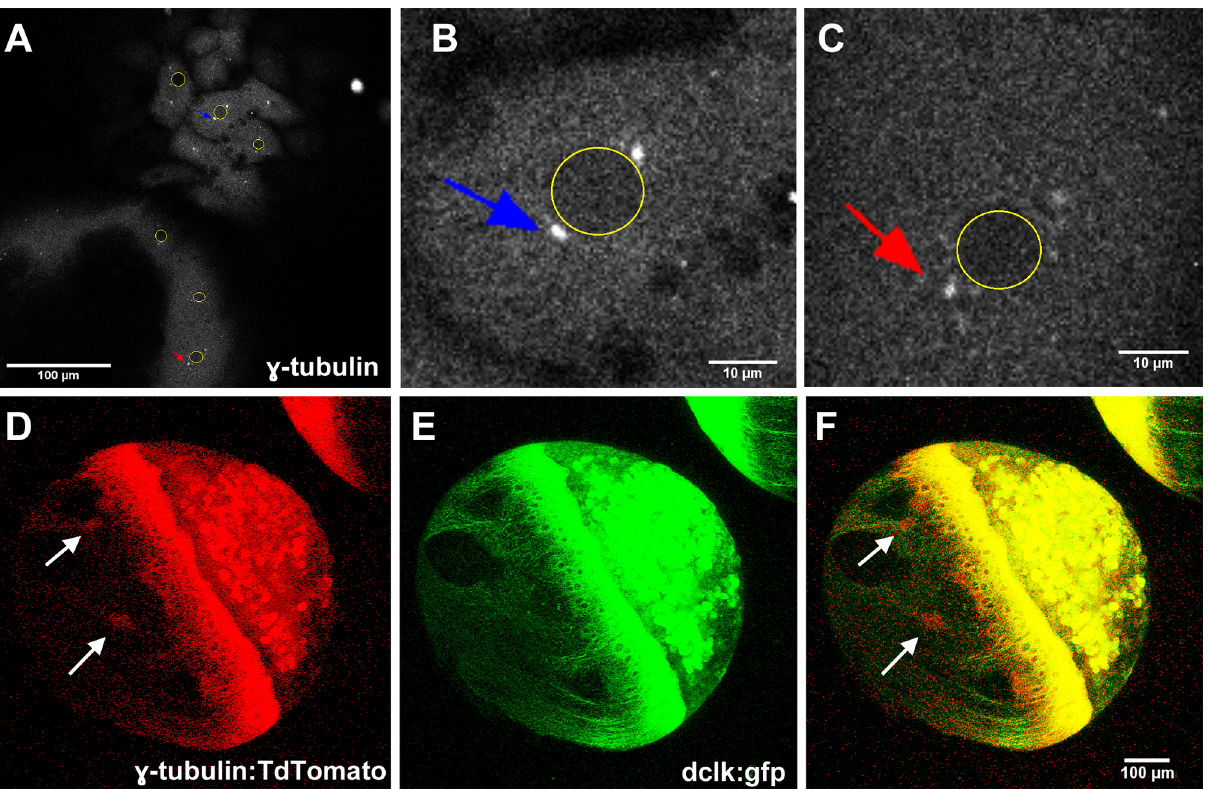
Figure 6. MT nucleation occurs at YSN centrosomes and YCL asters. γ-Tubulin expression can be observed through ( A – C ) immunostaining on fixed embryos and ( D – F ) in embryos coinjected with γ-tubulin-TdTomato mRNA and dclk2-gfp mRNA. γ-Tubulin signal has been found in ( B ) blastoderm centrosomes (blue arrow), ( C ) e-YSN centrosomes (red arrow) and ( D – F ) YCL asters colocalizing with dclk2-GFP signal (white arrows). In ( A – C ) the nuclei of both blastoderm and eYSN have been highlighted (yellow